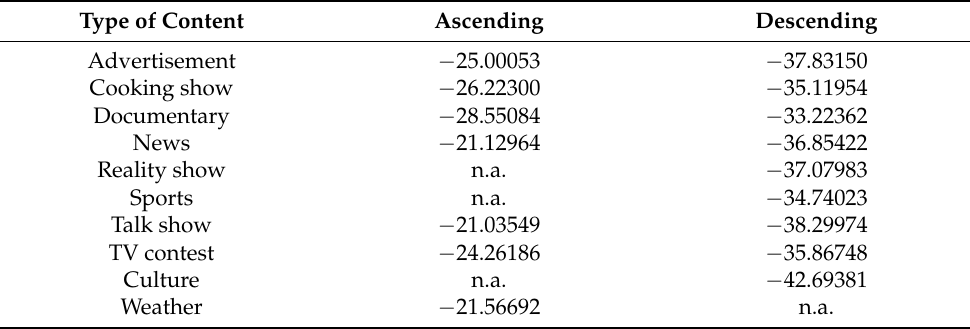
Table 2. Mean threshold values per type of video and experiment